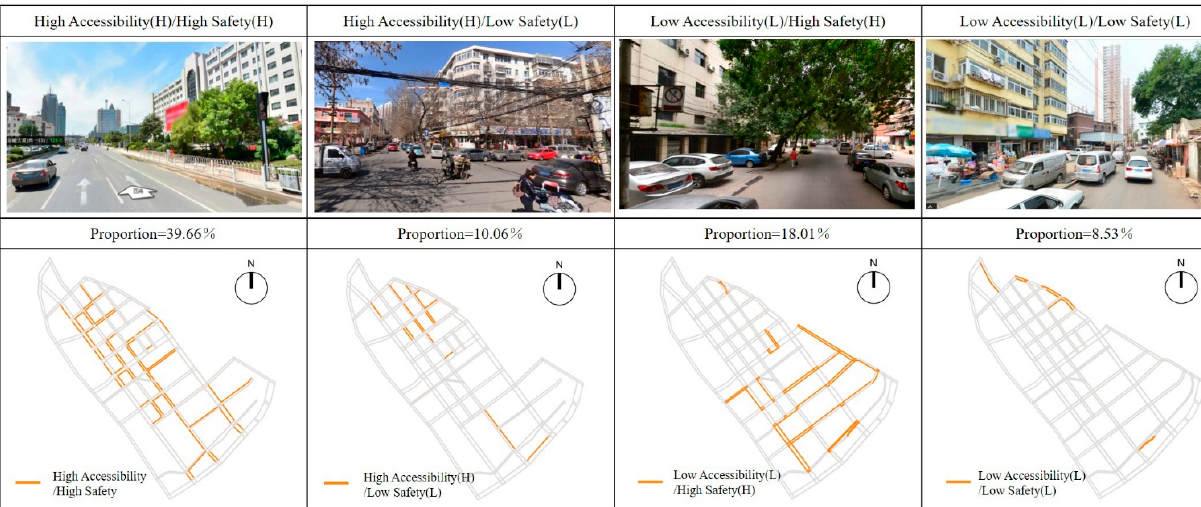
Figure 22. Typical Street scenes and distributions of the four types of streets after optimization.